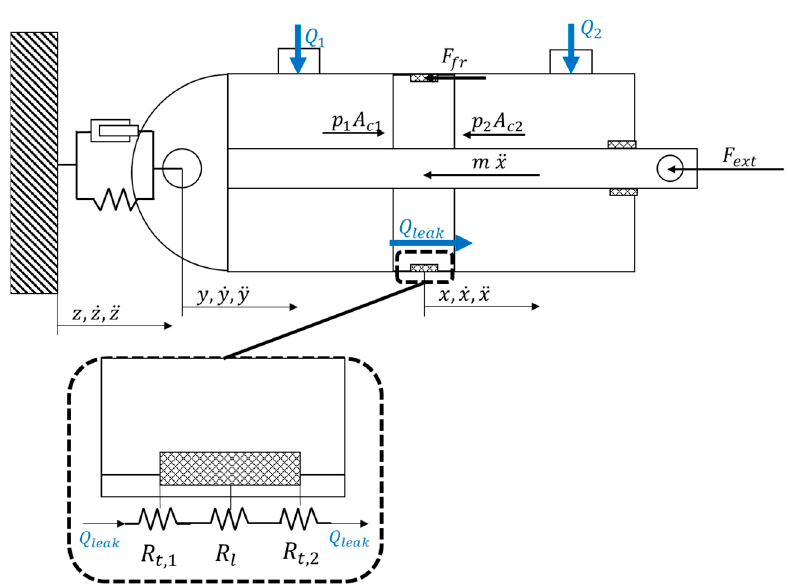
Figure 3. Overview of the actuator model.